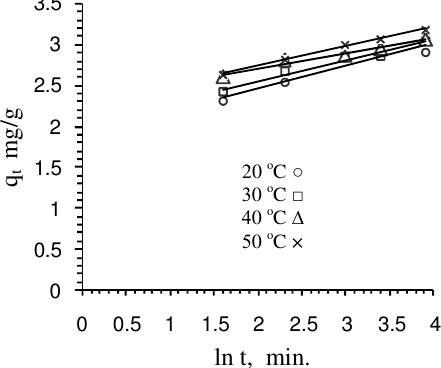
Figure 12 . Elovich kinetic for the adsorption of Cr(VI) onto MPGP .